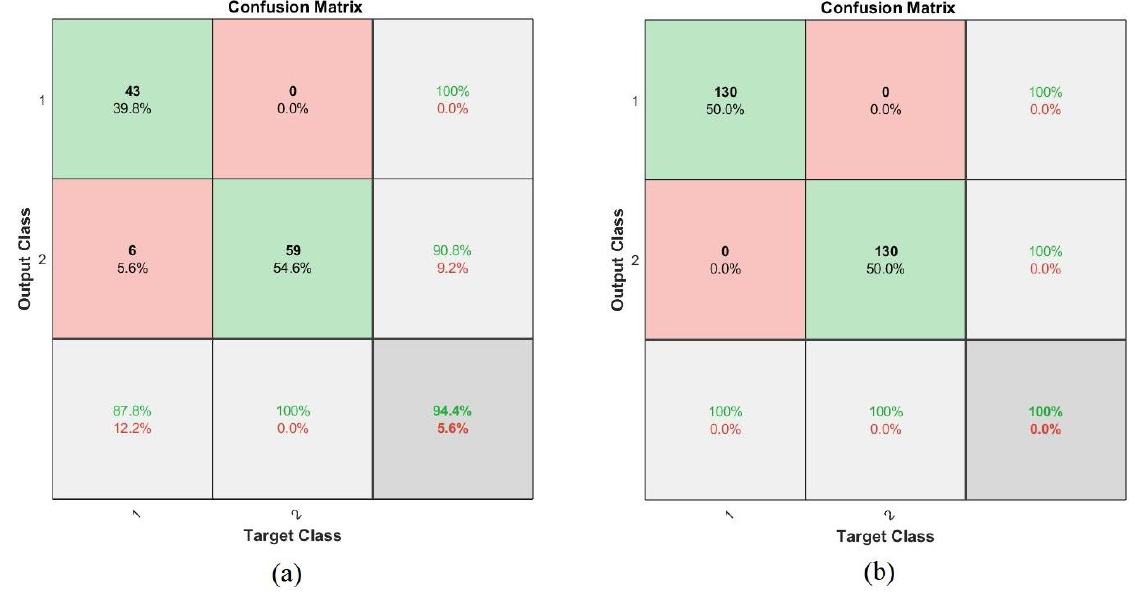
Figure 18. Confusion matrix for the ANN algorithm of the ( a ) ALL_IDB1 and ( b ) ALL_IDB2 datasets.